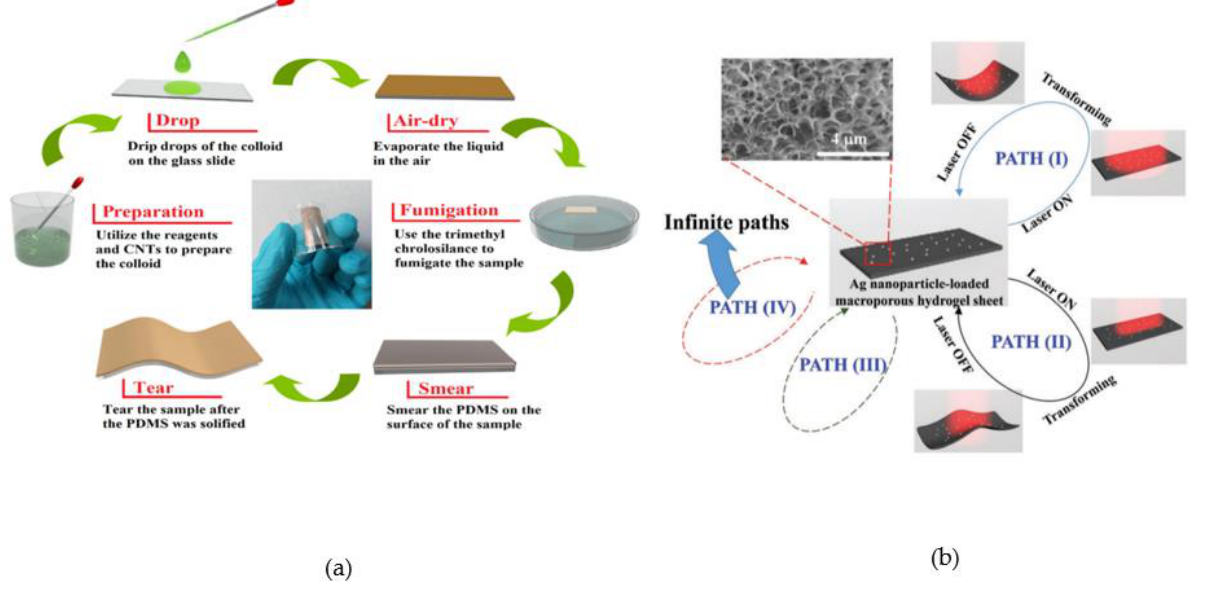
Figure 6. A shape transforming sensor triggered by light, reprinted with permission from [58]. ( a ) Drop-casting fabrication method, nanocolloid is deposited onto a flexible substrate. ( b ) Different shape transformations of the sensor depending on the position on which the sensor is exposed to light.